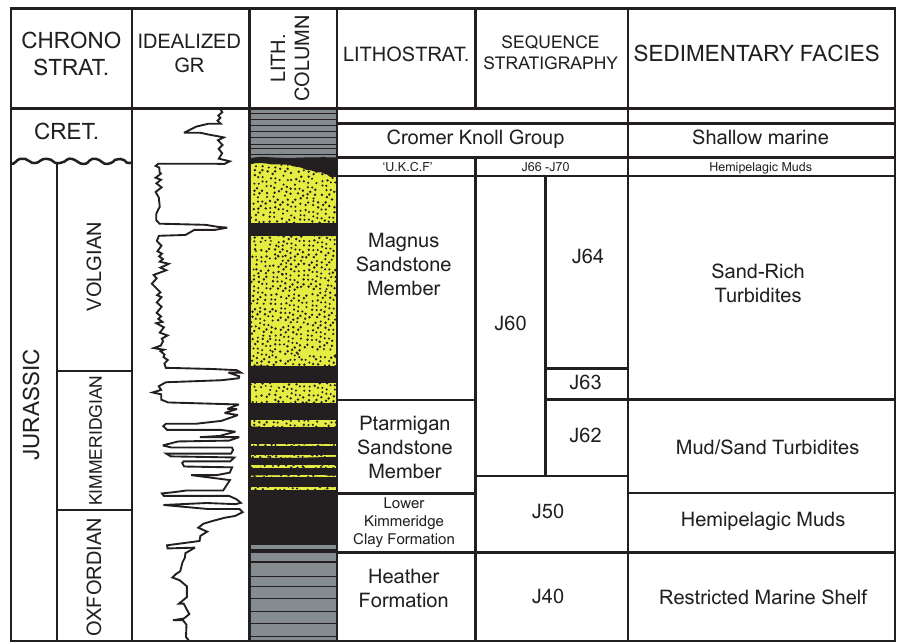
Figure 9. Stratigraphy of the reservoir interval in the Magnus Field, northern North Sea [59,60,62]. Yellow = sandstone, grey = mudstone, black = high-gamma (organic-rich)